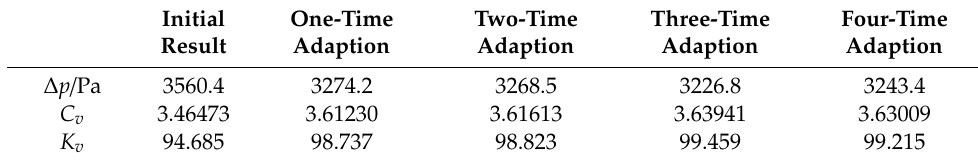
Figure 10. The meshes of three-time velocity adaptation ( a ) velocity gradient and y + hybrid adaptation; ( b ) and their results of calculation (Tables 2 and 3), respectively. Table 2. Result of Velocity gradient adaptive calculation.